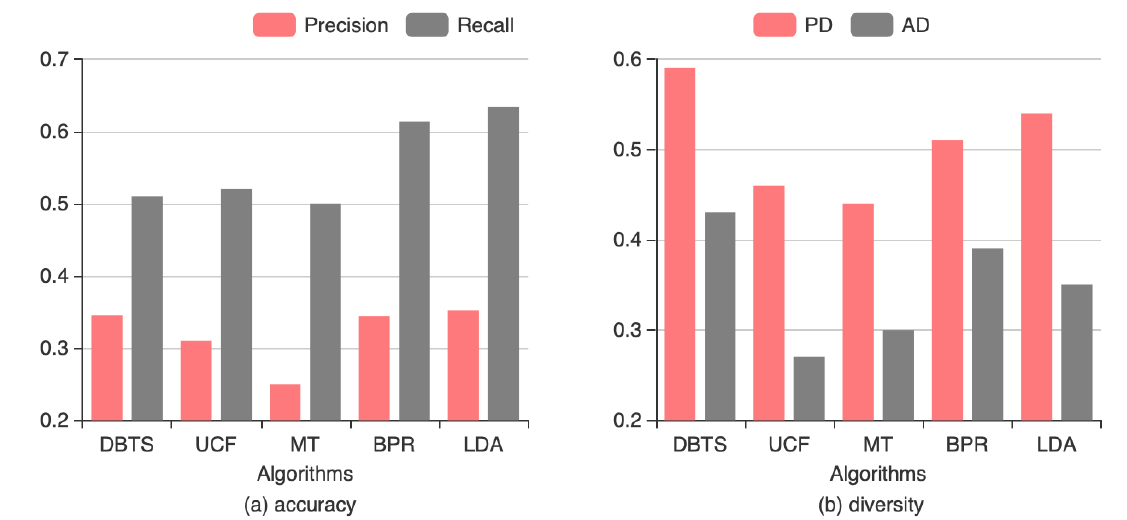
Figure 6. Comparison of ( a ) accuracy and ( b ) diversity between DBTS and other algorithms.